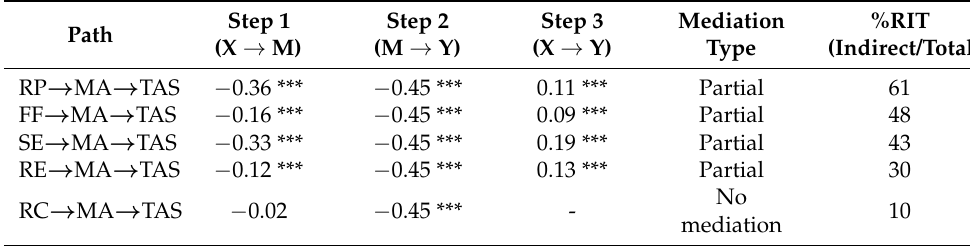
Table 8. Mediation effect according to the Baron Kenny